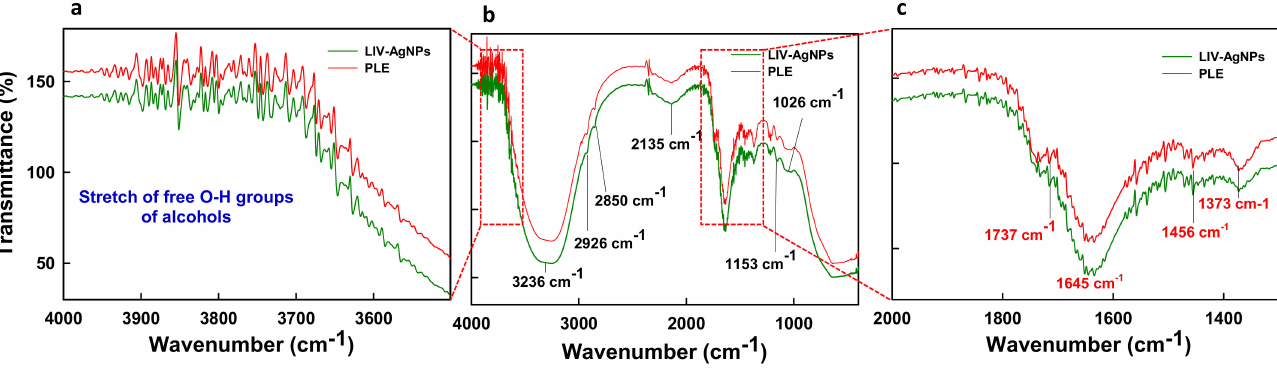
Figure 4. FTIR analysis of LIV-AgNPs. Panel ( a , c ) demonstrate feeble stretching signals of functional groups linked with bio-actives on PLE-alone (red) and LIV-AgNPs (green) in the range of 4000 to 3500 cm − 1 and 2000 to 15,000 cm − 1 , at high magnification, respectively. Whereas, panel ( b ) represents a comparative FTIR spectra analysis of PLE-alone and LIV-AgNPs at full scan scale at normal